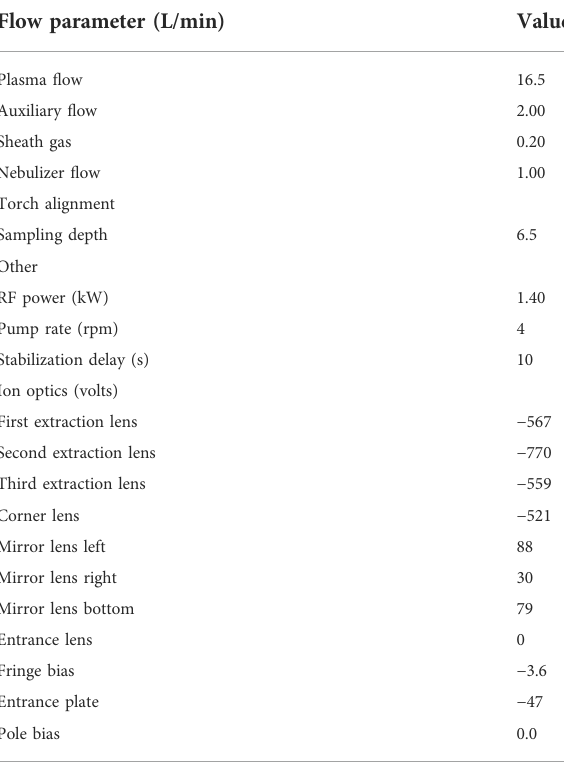
TABLE 1 Instrumental operating conditions for ICP-MS. TABLE 2 Speci fi c calibration range for the REEs. All values are expressed in µg/L.